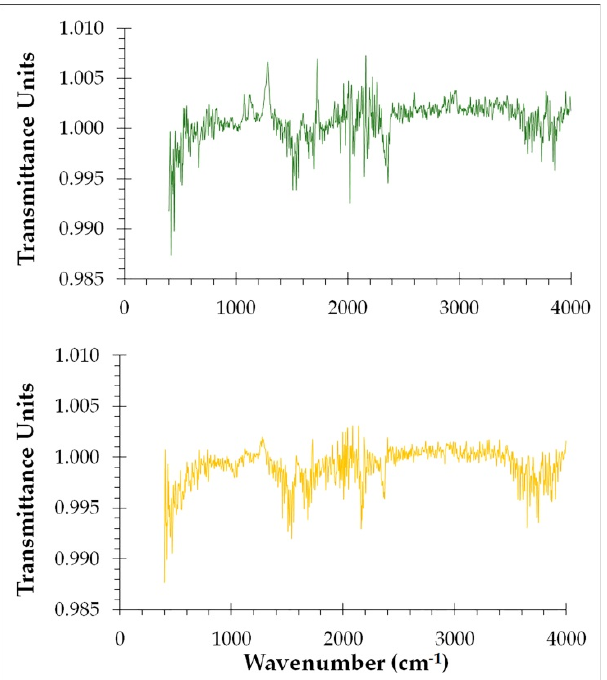
Figure 3. Attenuated Total Reflectance (ATR)-Fourier transform infrared spectroscopy (FTIR) spectrums of young ( ▬ ) and old ( ▬ ) lif fibers.